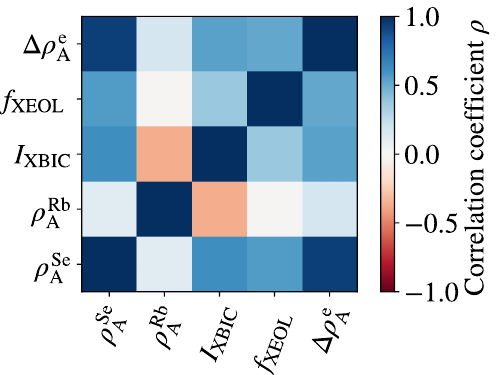
Figure 6. Correlation coefficient ρ for all combinations of the area density of Se ( ρ Se of the XBIC ( I XBIC ), of the XEOL photon count rate ( f XEOL ), and of the relative electron area density ( ∆ ρ e A